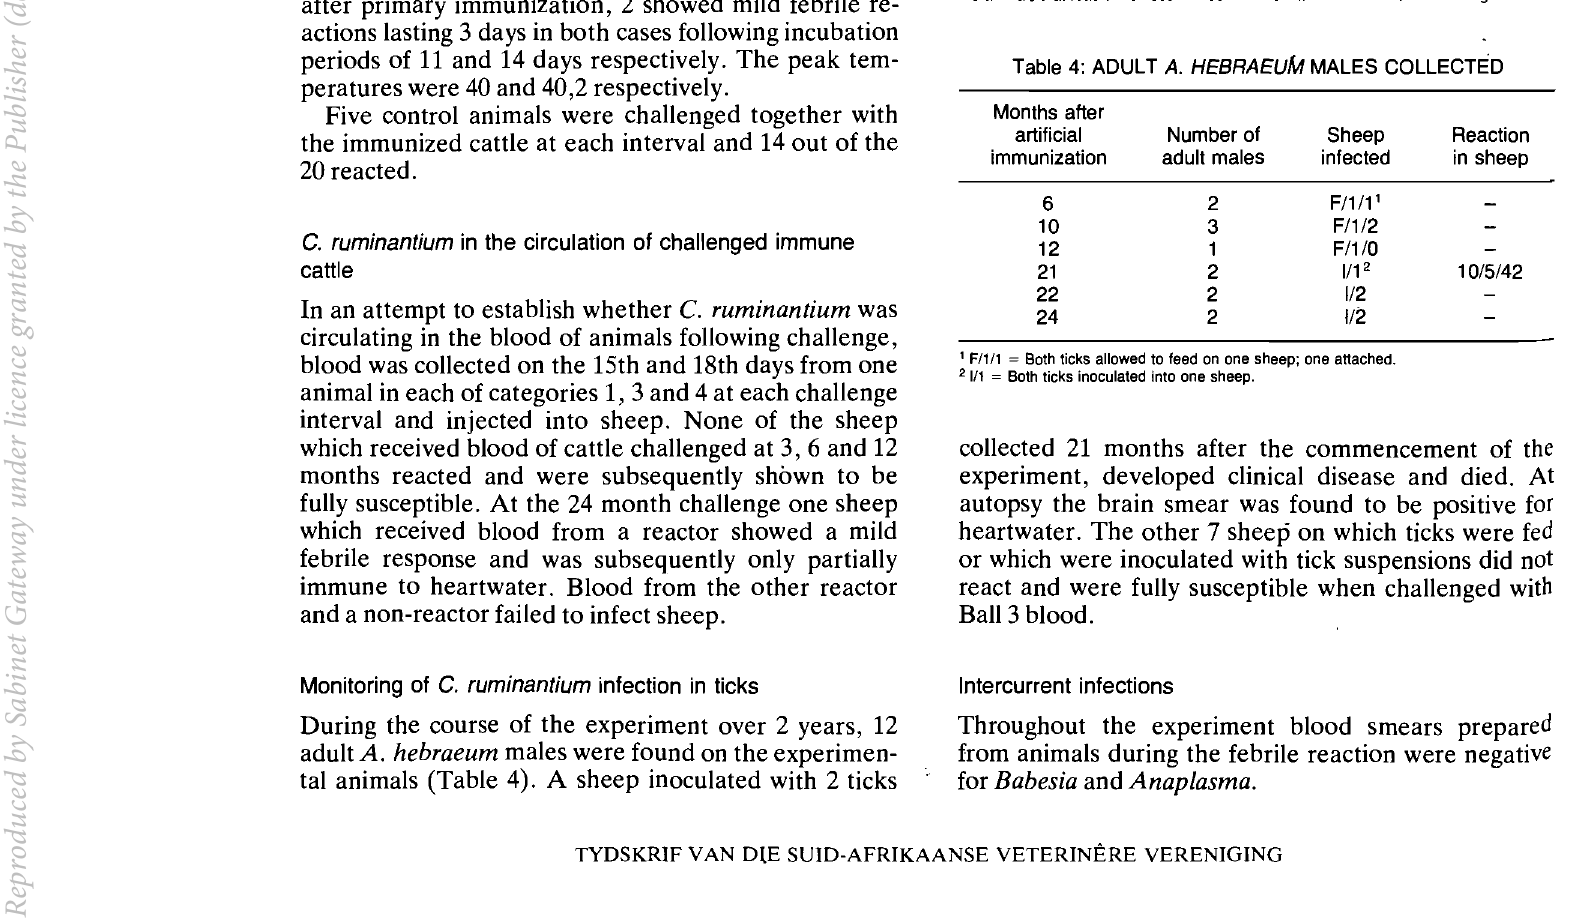
Table 2: RECIPROCALS OF CONGLUTININ TITRES AT THE TIME WHEN THE INOCULATIONS WERE GIVEN, OF 3 CATTLE THAT REACTED TO A SECOND INOCULATION ONLY Bovine No.